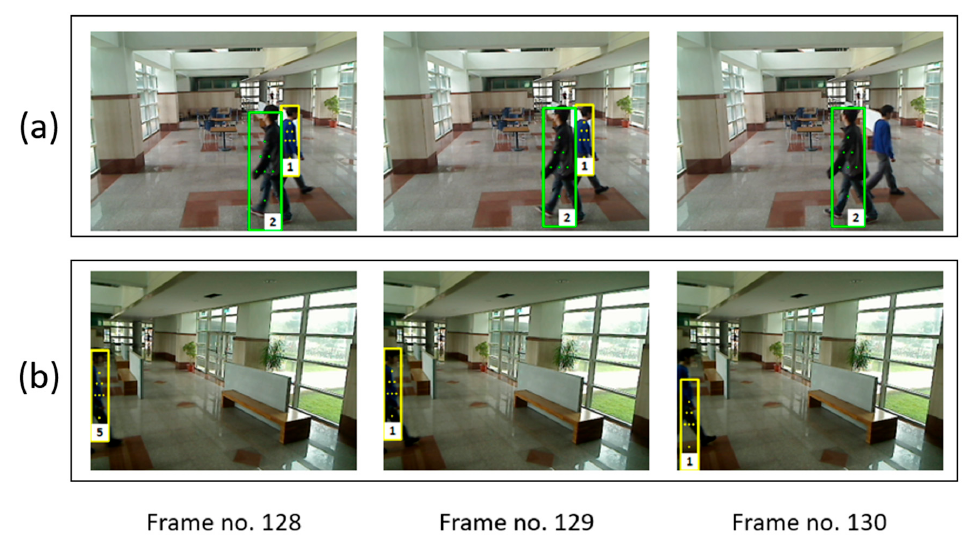
Figure 17. Object2: Frame no. 188~203 from Cam1 in two people tracking scene.